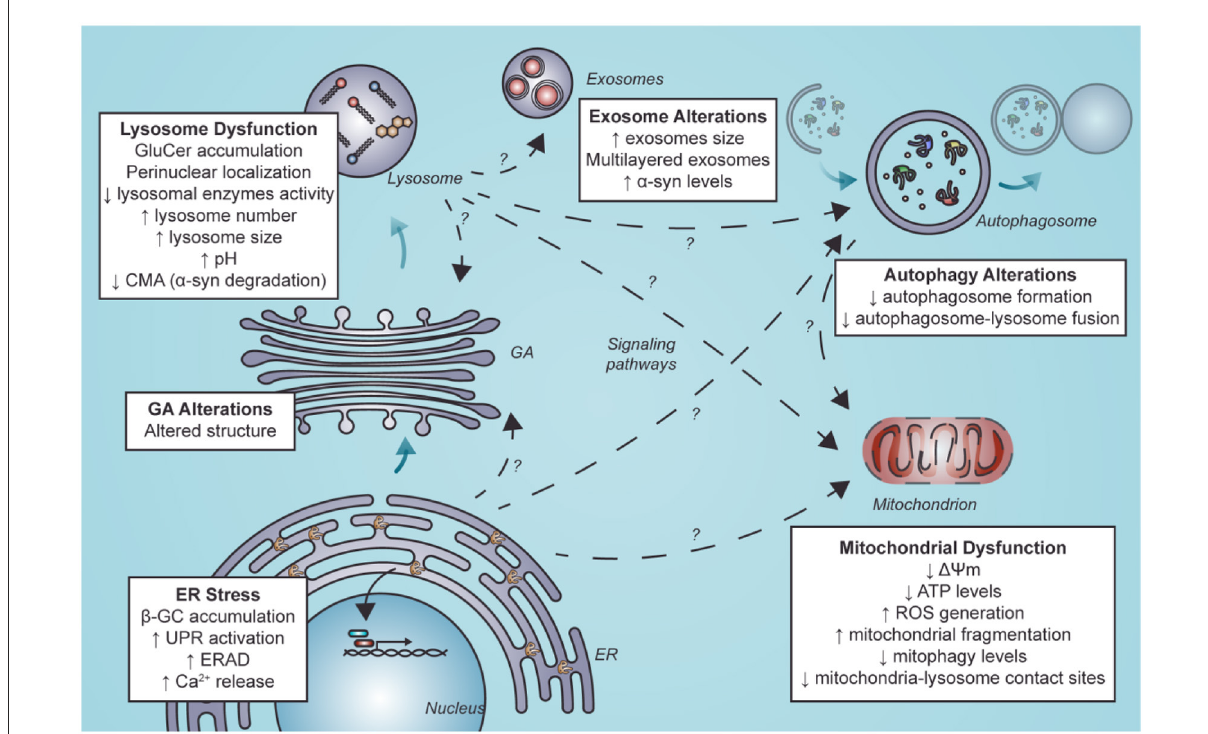
FIGURE3 Secondary organelle dysfunction in nGD following ER stress and lysosome dysfunction. Lysosome dysfunction is characterized by GluCer accumulation, perinuclear localization of LIMP2-positive structures, diminished lysosomal enzymes activity, elevated lysosome number and size, alkalinization of lysosomes and decreased levels of CMA. Furthermore, GluCer accumulation and ER stress mediated by β -GC misfolding can alter other organelles. These alterations could be mediated by direct interaction with other organelles. They could also result from indirect interactions between lysosomes and other organelles by activating signaling pathways or alterations in these organelles such as exosomes, autophagosomes in autophagy, mitochondria, and GA. Alterations in autophagy and mitochondria have been well described. Still, little is known about the mechanisms that lead to these alterations and less about alterations in other organelles such as exosomes and GA (segmented arrows with a question mark). GluCer, glucosylceramide; CMA, chaperone-mediated autophagy; ER, endoplasmic reticulum; β -GC, β -glucocerebrosidase; GA, Golgi apparatus; ERAD, endoplasmic reticulum-associated degradation; ROS, reactive oxygen